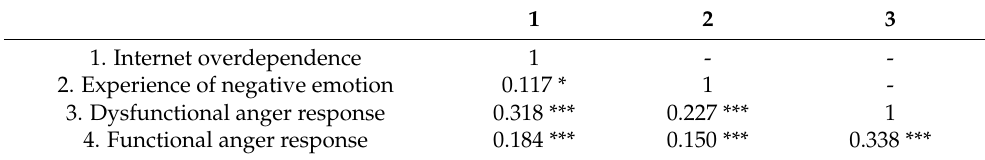
Table 3. Analysis of